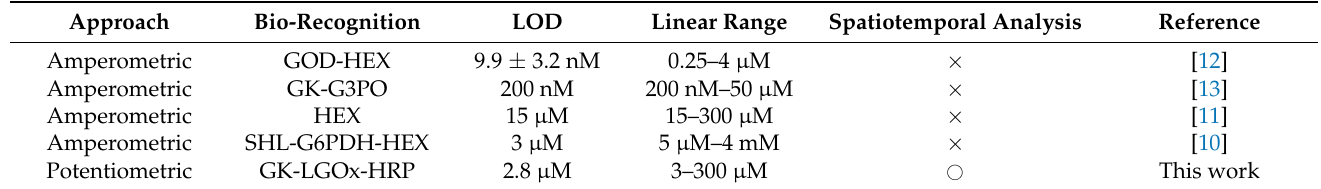
Table 2. Comparison of analytical characteristics of the proposed ATP image sensor with other electrochemical biosensors for ATP measurement.